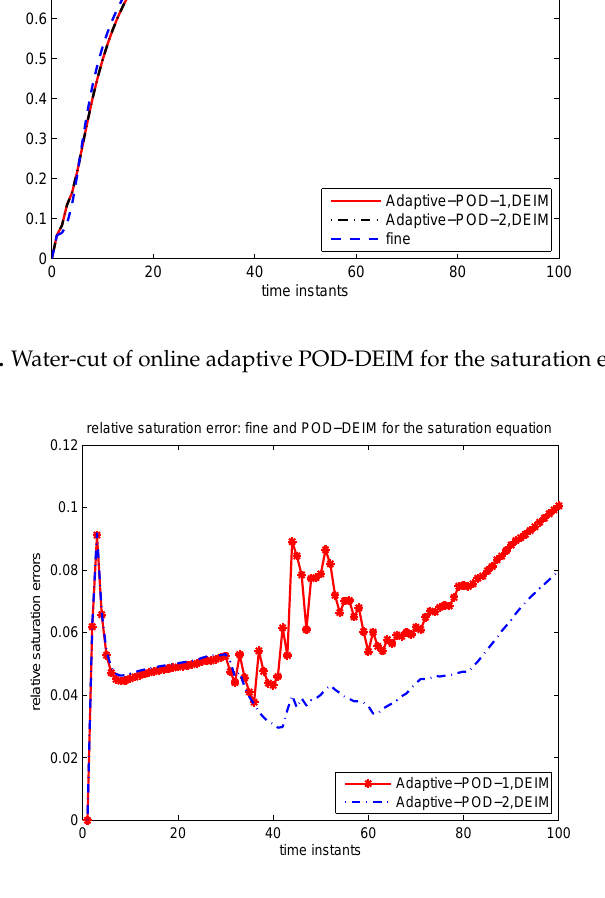
Figure 14. Relative saturation errors advancing in time: POD-DEIM for the saturation